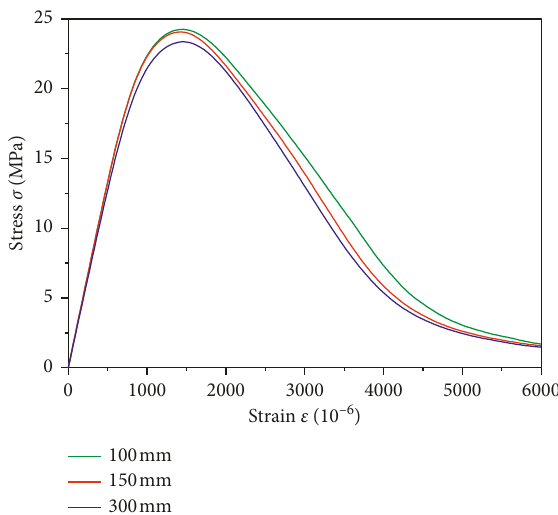
Figure 22: Macrocompressive stress-strain curve of concrete for different size